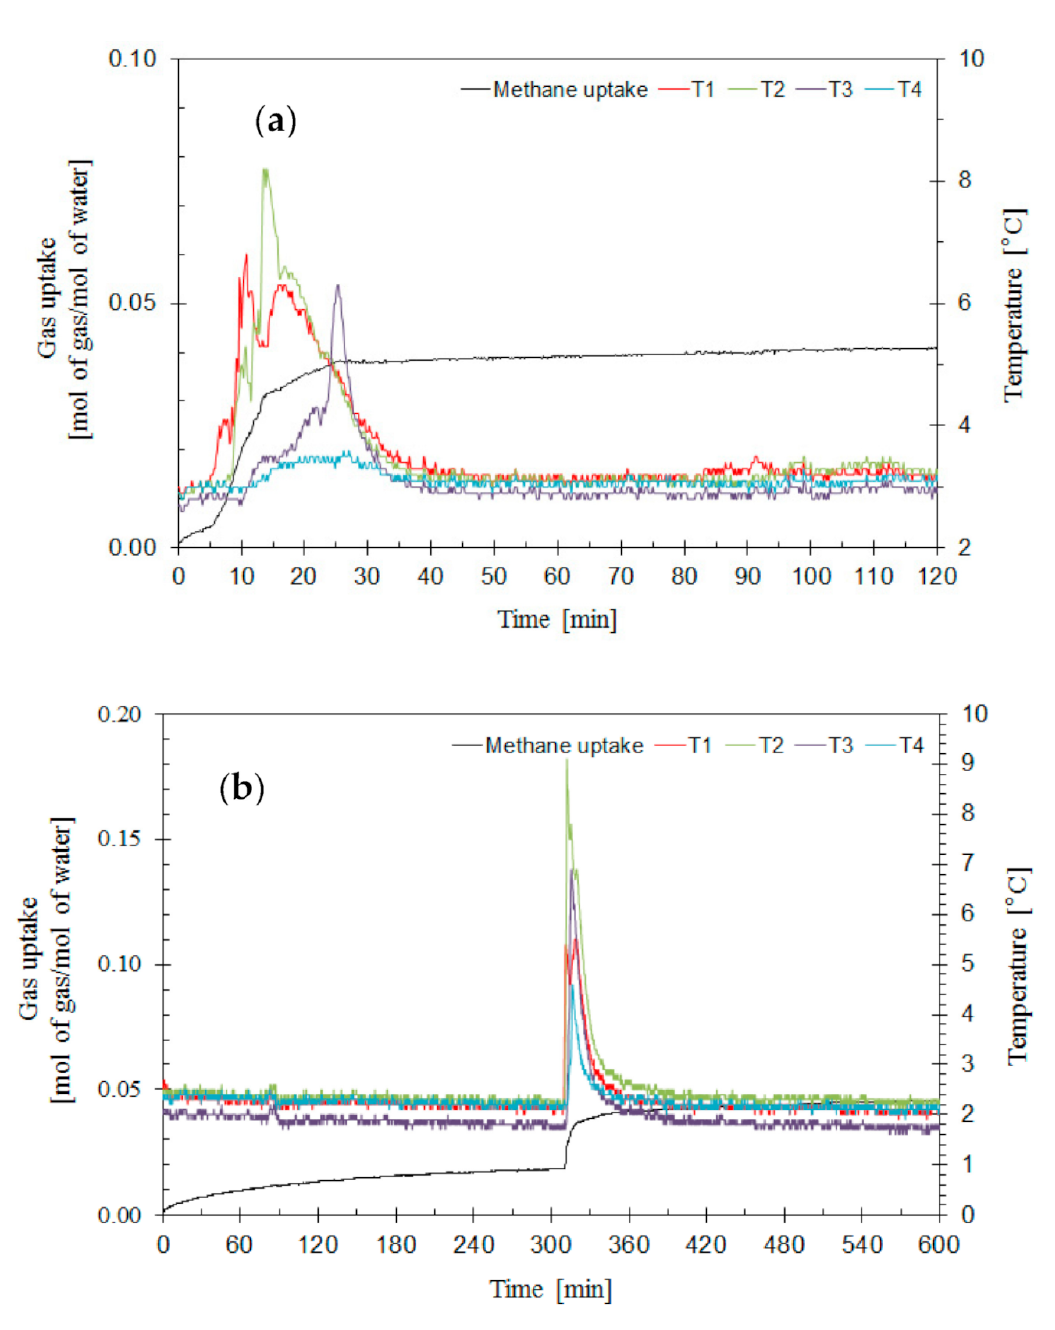
Figure 8. Methane uptake and temperature profiles during the methane hydrate formation experiments performed with CP at 2.5 ◦ C: ( a ) 10% v / v (Experiment 16, Table 2), ( b ) 15% v / v (Experiment 20, Table